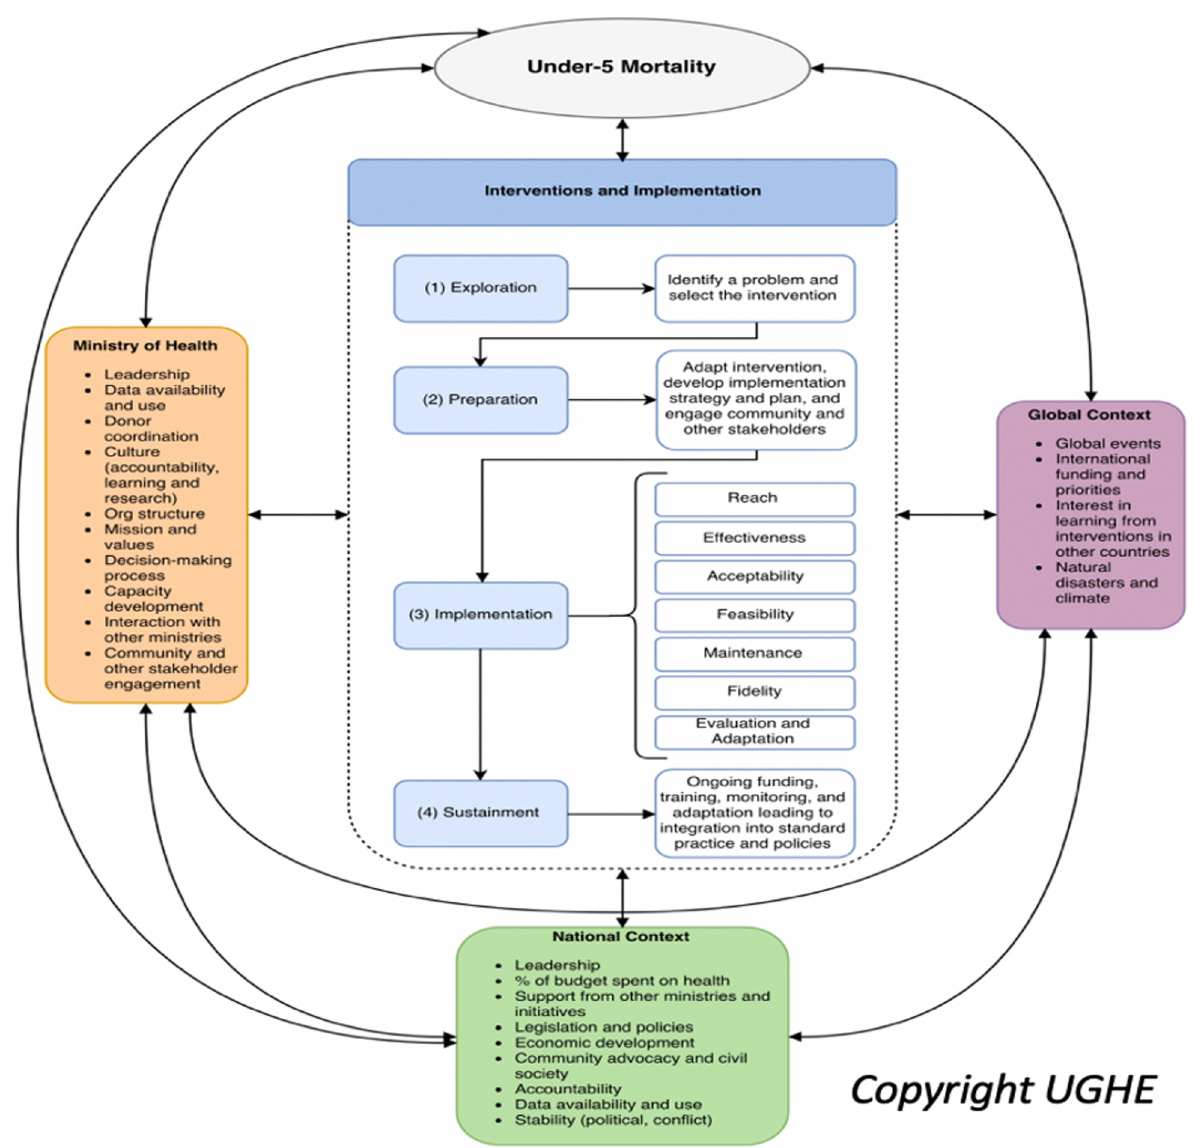
Figure 1. Hybrid Framework for Understanding Interventions to Reduce Under-5 Mortality. Reproduced with the permission of